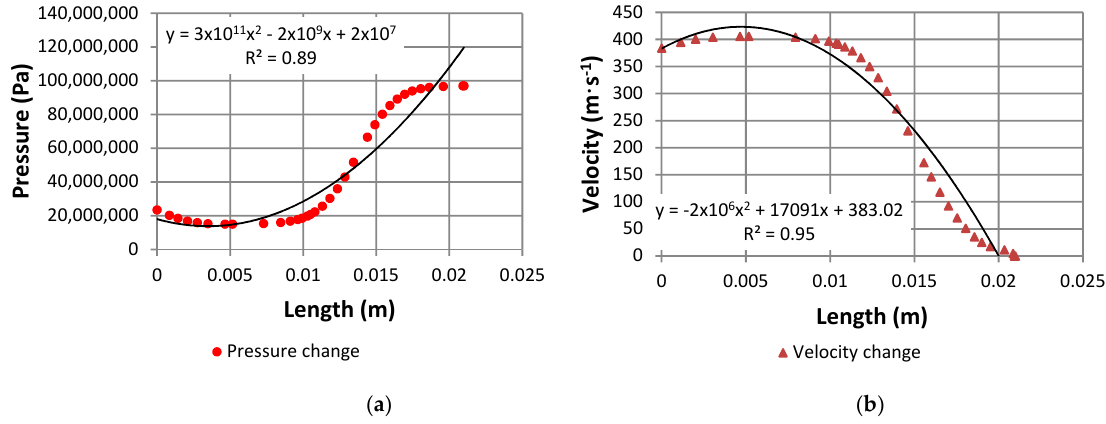
Figure 14. The variation curves of pressure ( p ) ( a ) and velocity ( υ ) ( b ) for volume flow rate 0.01335m 3 ·s -1 (800 L·min -1 ).